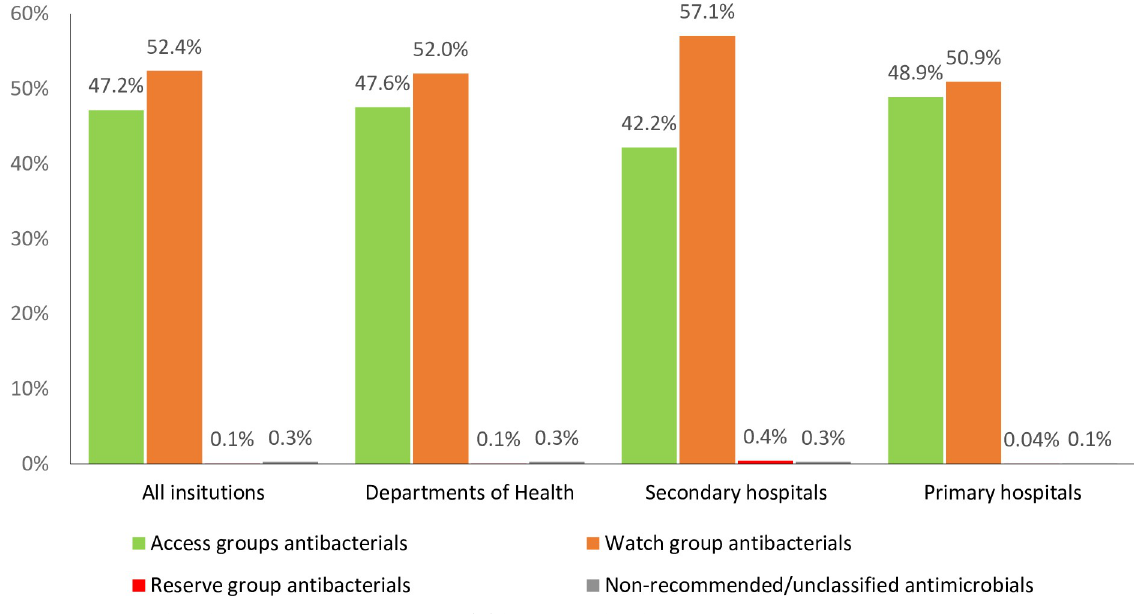
Fig 1. Proportional antibacterial procurement in DDD (%) by AWaRe